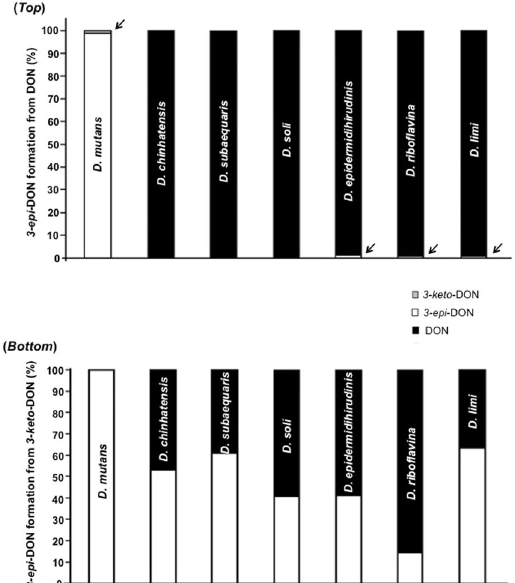
Figure 6. The ability of different Devosia type-strains to epimerize DON or to selectively reduce 3-keto- DON to 3-epi- DON. The simultaneous oxidation and reduction of the C3 carbon (epimerization) in DON ( Top ) or the selective reduction of 3-keto- DON to 3-epi- DON ( Bottom ) were tested after growing the pure isolates within the respective media preparations recommended by type-strains suppliers (DMSZ & ATCC culture collections). The concentrations of DON, 3-keto- DON, and 3-epi -DON were monitored as reported within the Materials and Methods section (after 24 h incubations). While experiments were conducted in triplicates to confirm the observed tendencies, no quantitative statistical inferences between strains are suggested. The incorporated arrows highlight the presence of traces of different DON